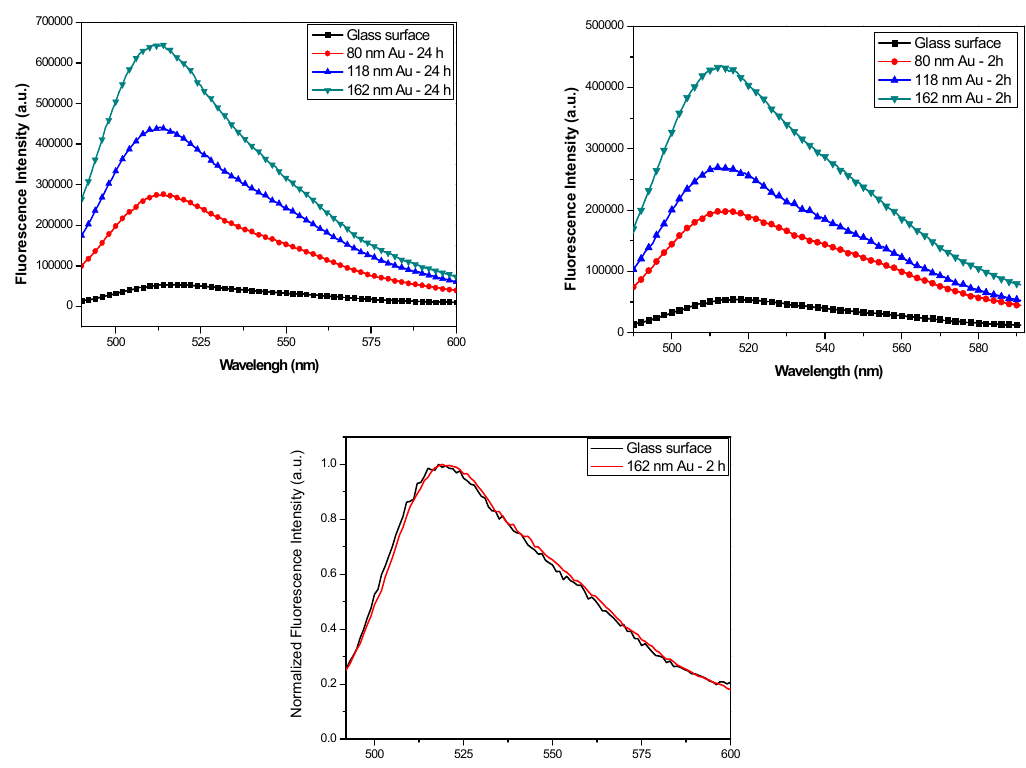
Figure 8. Fluorescence emission intensity of FITC-HSA: (a) on substrate with 2 hours incubation time (from top to bottom): 162 nm Au colloid; 118 nm Au colloid; and 80 nm Au colloid. (b) on substrate with 24 hours incubation time (from top to bottom): 162 nm Au colloid; 118 nm Au colloid; and 80 nm Au colloid. (c) Normalized emission spectra of FITC-HSA on glass and on metallic surface